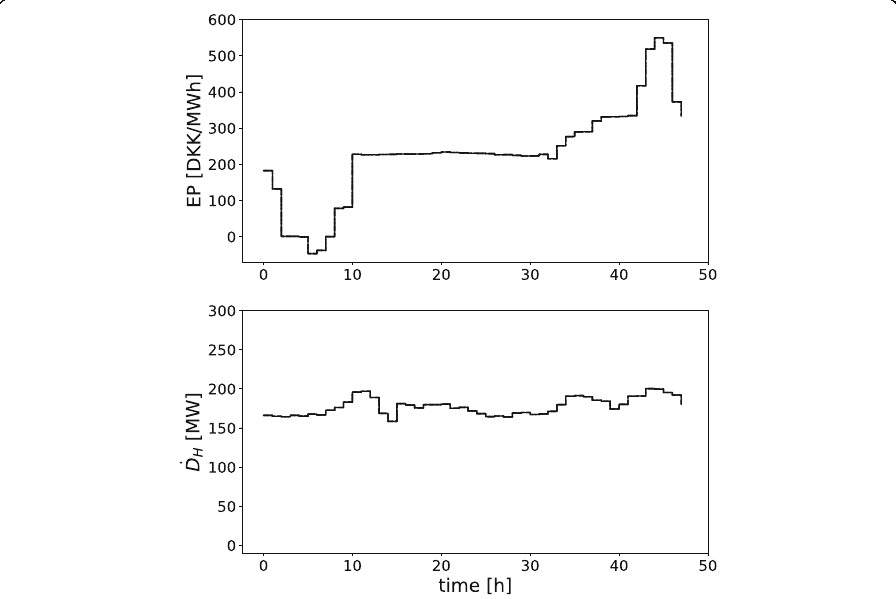
Fig. 7 Electricity price (top) and heat demand (bottom) of the